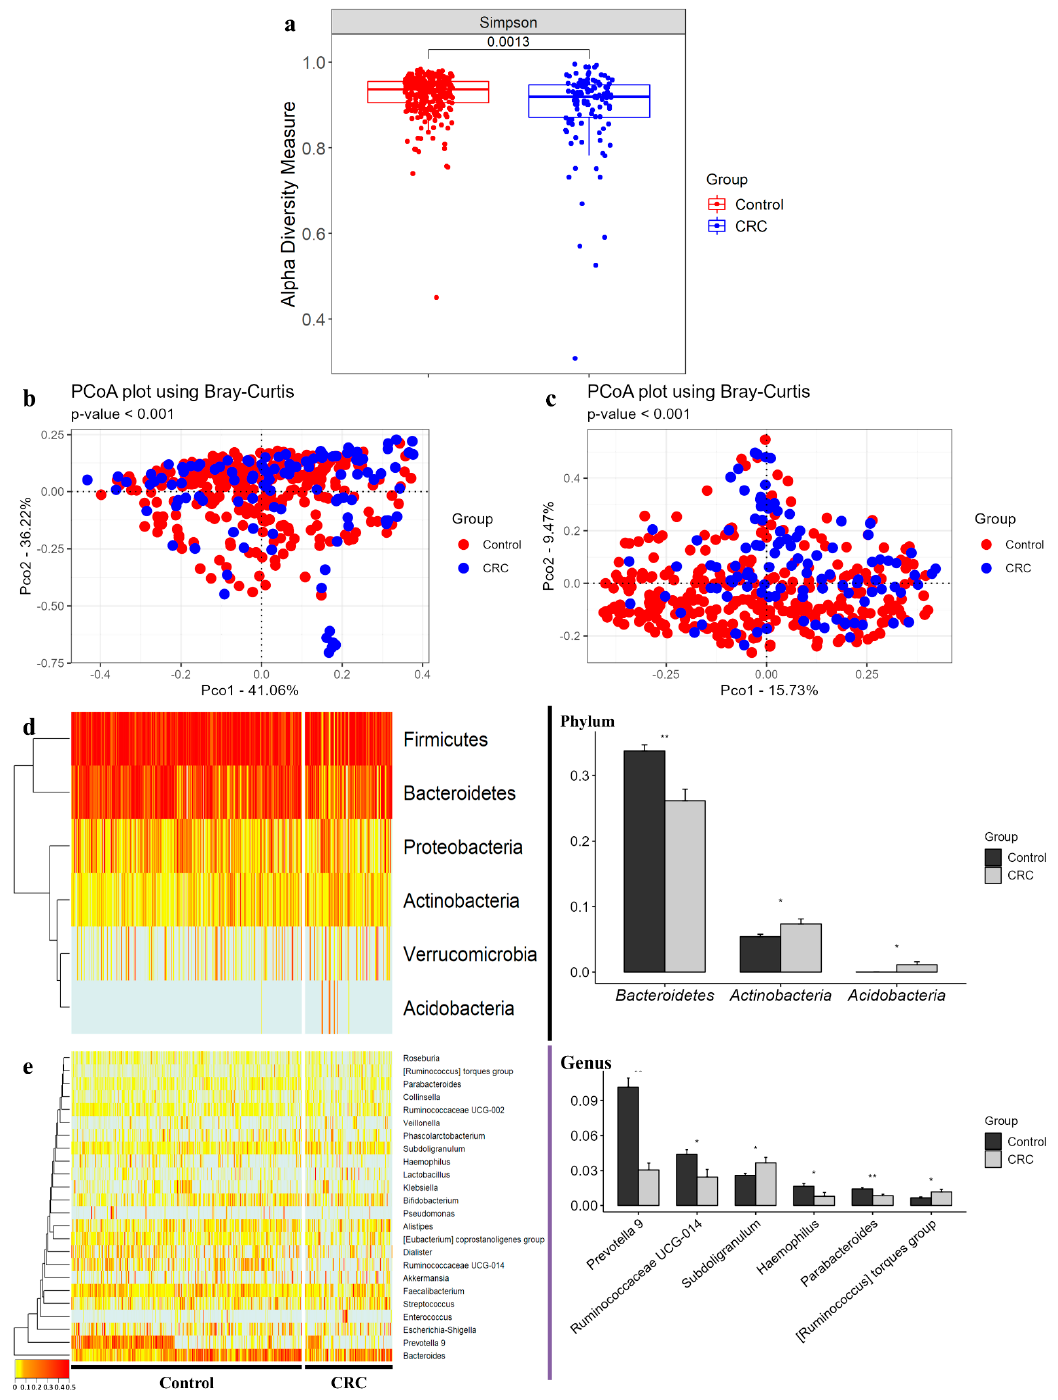
Figure 2. Alpha diversity, beta diversity, and compositions of microbiota at phylum and genus levels in CRC clinical samples. ( a ) Alpha diversity was defined by Simpson index. Beta diversity based on Bray-Curtis dissimilarity was measured at ( b ) phylum and ( c ) genus levels. Left-side heatmap plots and hierarchical clustering dendrograms show microbial compositions between individual samples of control and CRC groups at ( d ) phylum and ( e ) genus levels. Right-side bar plots highlight different average relative abundance of individual key taxa between the control and CRC subject stool microbiota at ( d ) phylum and ( e ) genus levels. Significance between groups was assessed by a t -test (*, p < 0.05; **, p <